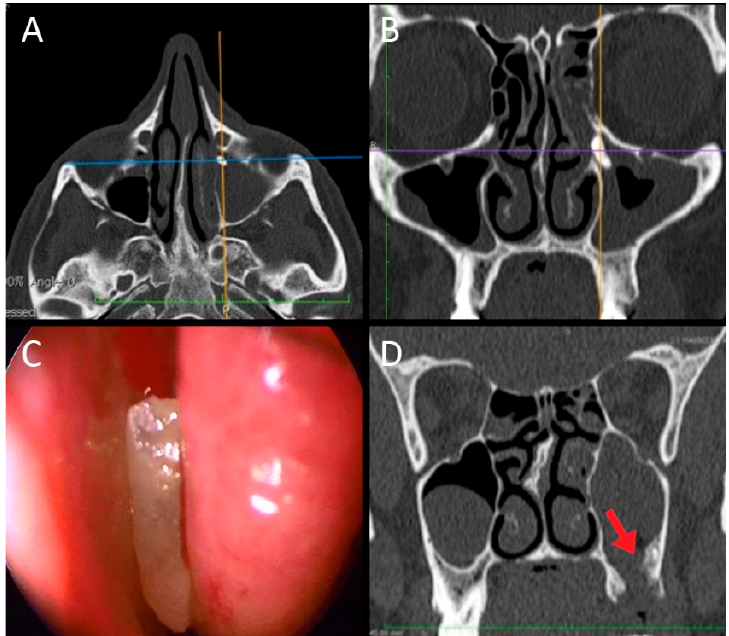
Figure 5. Male patient, 61 years old, complaining of sinus pain, nasal obstruction, and rhinorrhea. CT (( A ): axial scan; ( B ): coronal scan) revealed the presence of a foreign body in the left osteomeatal complex. Endoscopic surgery was performed to remove the foreign body ( C ) and to clean the maxillary sinus. Because of wide oroantral fistula ( D ), red arrow surgical closure using a local mucosal flap was required.